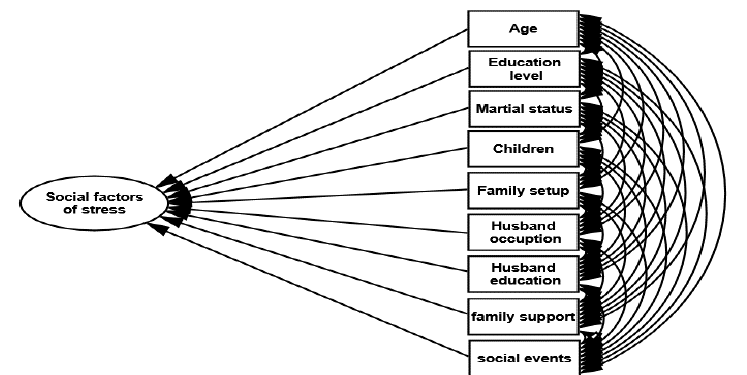
Figure 9. Hypothetical model of social factors.